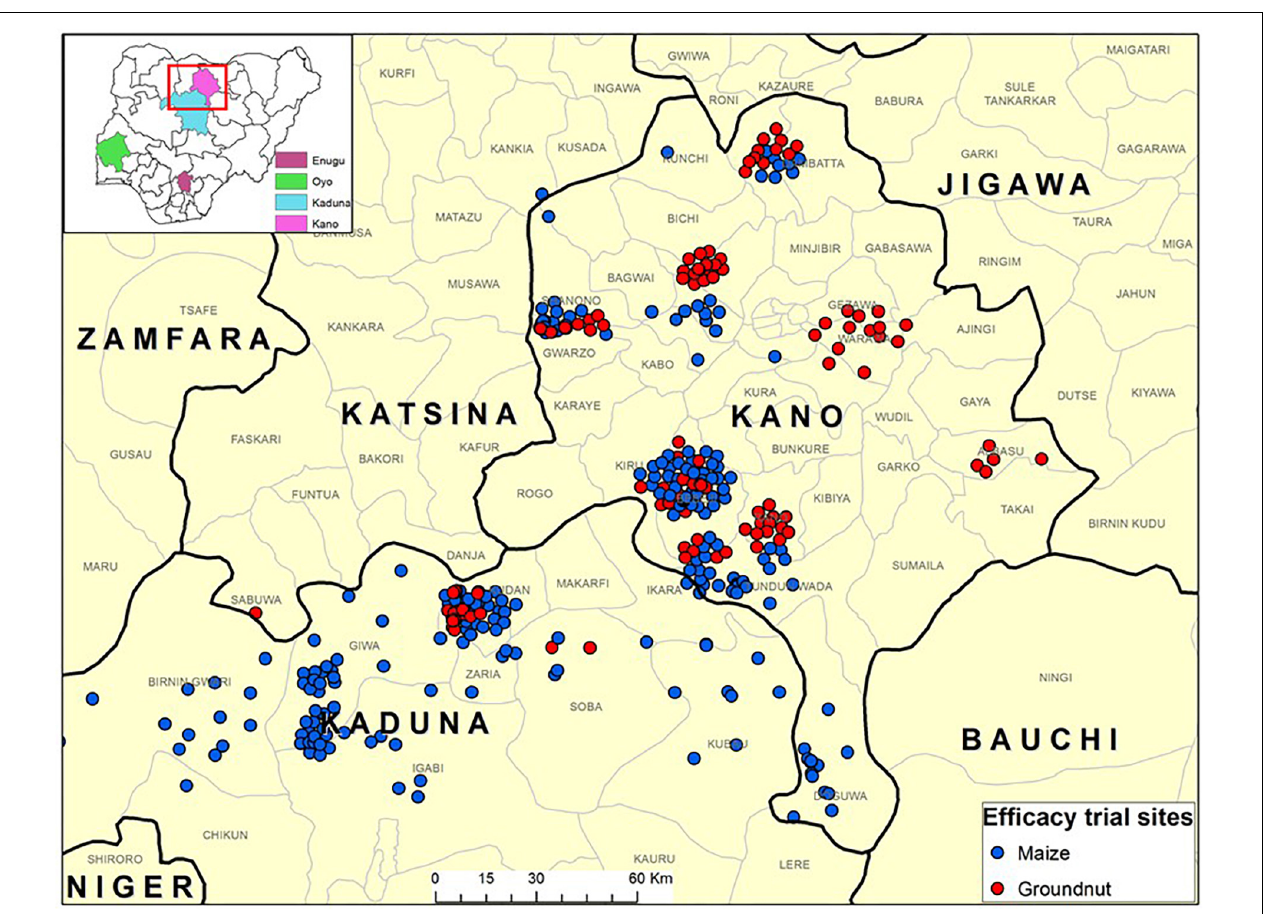
FIGURE 1 | Map of various states of Nigeria (inset) where efficacy trials of an atoxigenic biocontrol product were conducted by maize and groundnut farmers for aflatoxin mitigation during 2009 to 2012. Majority of the trials were conducted in Kano and Kaduna states while a few were conducted in Enugu and Oyo states